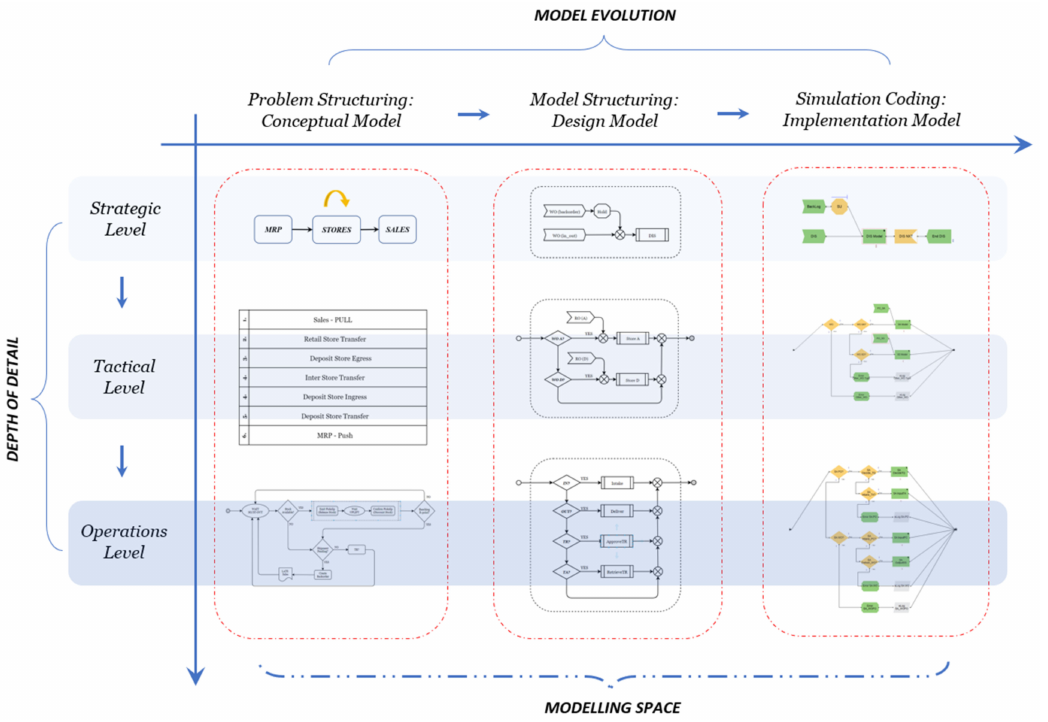
Figure 28. Modelling Space populated with representative models from the case